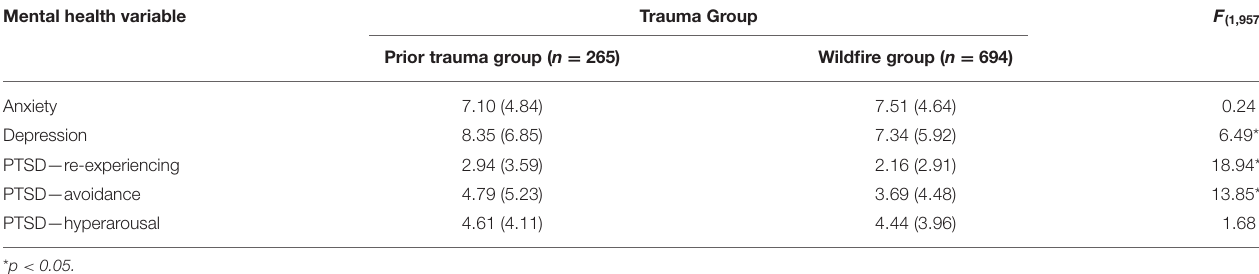
TABLE 3 | Means (SD) of mental health variables and MANCOVA results of differences between the prior trauma and wildfire groups, while controlling for age and sex.